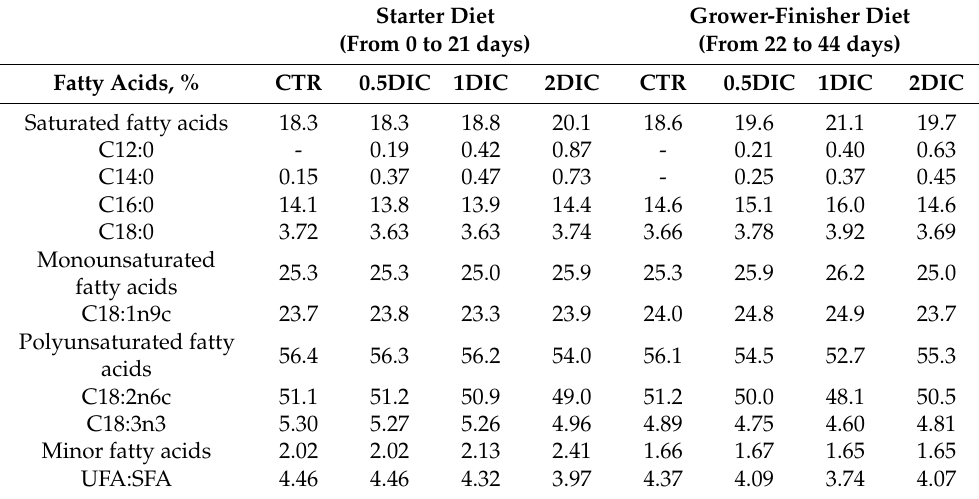
Grower-Finisher Diet (From 22 to 44 days)